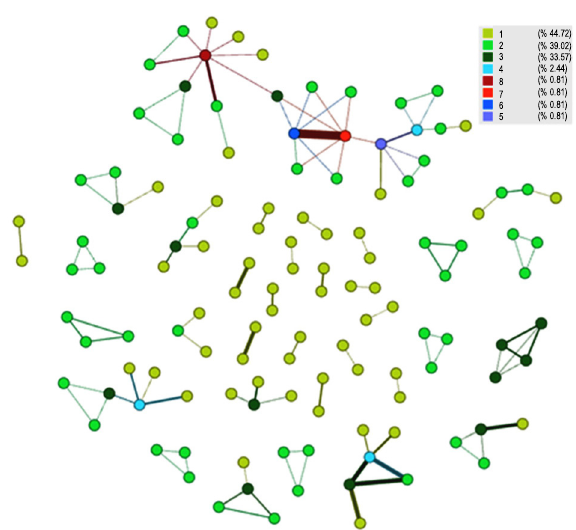
Fig. 6. Middle East market network